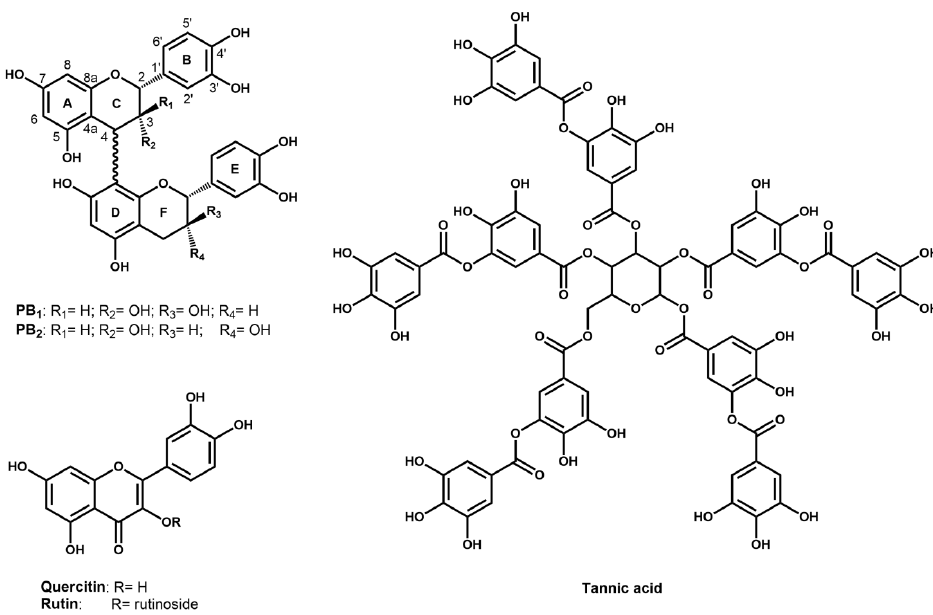
Figure 2. Chemical structures of proanthocyanidins B1 (PB1) and B2 (PB2), quercetin, rutin, and tannic acid.